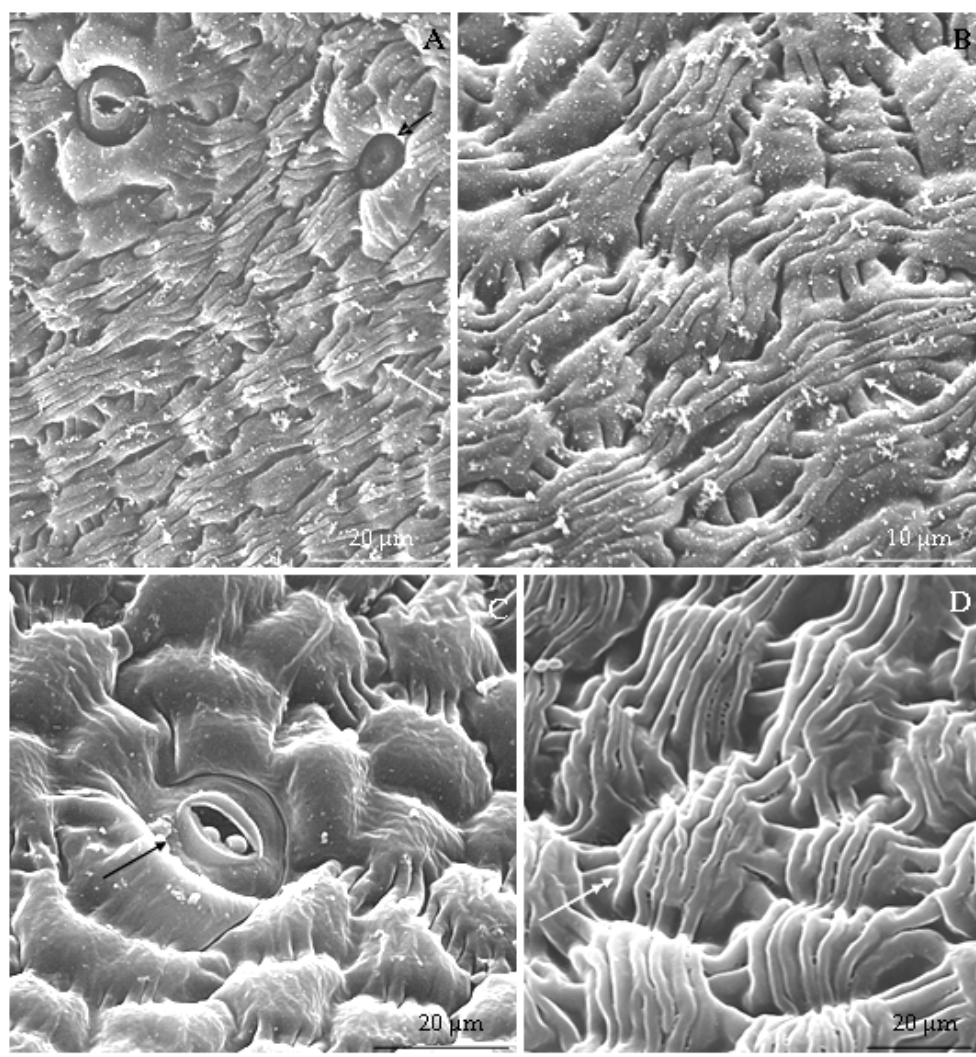
Figure 7. ( A – D ). Fragments of the nectary epidermis surface in the initial secretion phase in R. idaeus ‘Radziejowa’ ( A , B ) and ‘Pokusa’ ( C , D ). ( A ): striated cuticle, stomata in various stages of development (arrow); straight striae arranged closely next to each other (double-headed arrow). ( B ): continuous cuticular bands (double-headed arrow) on the surface of several epidermis cells along their longer axis; visible short striae between the bands. ( C ): open stoma (arrow); cuticular striation. ( D ): distinct bands on the surface of epidermis cells (double-headed arrow) and short striae in the interband region connecting adjacent cells.